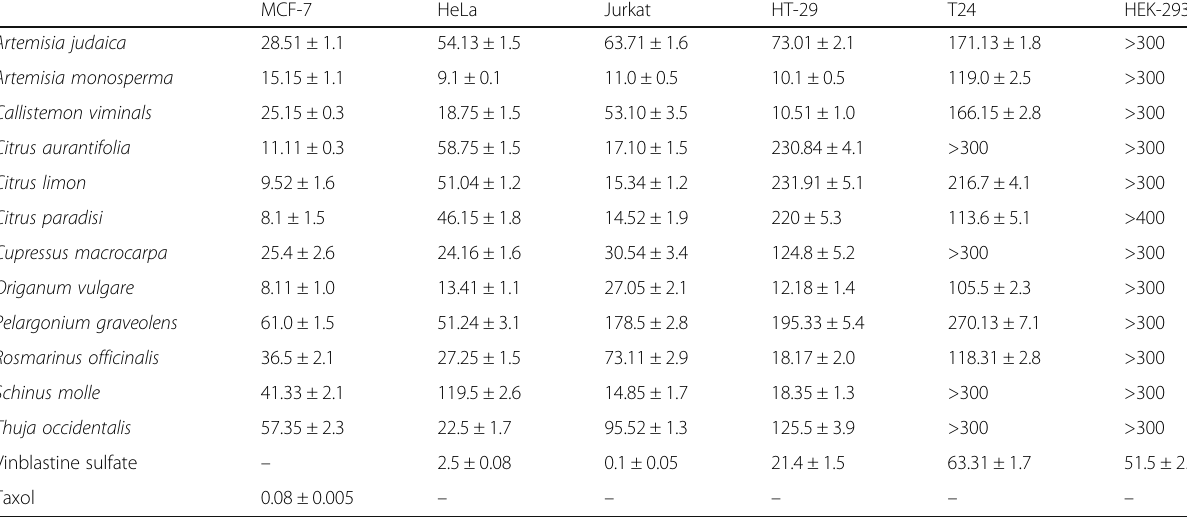
Table 7 In vitro antiproliferative activity [IC 50 ( μ g/ml)] of twelve aromatic plants essential oils on cancer cell